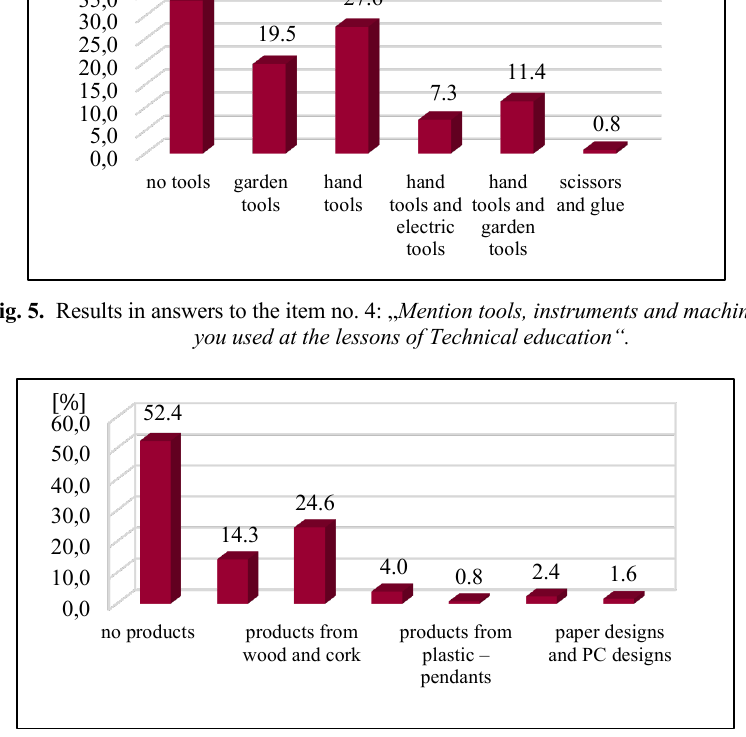
Fig. 6. Results in answers to the item no. 5: „ Mention products you designed or manufactured at the lessons of Technical